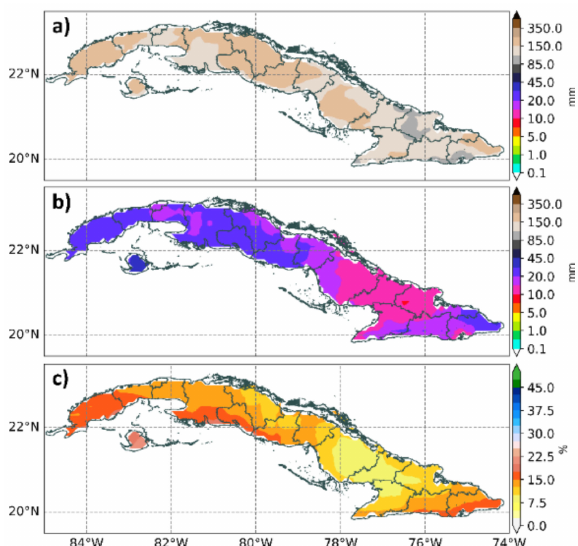
Figure 11. Mean values of ( a ) total precipitation, ( b ) total TC–related precipitation, ( c ) percentage of TC–related precipitation with respect to the total. Period: June-November from 1980 to